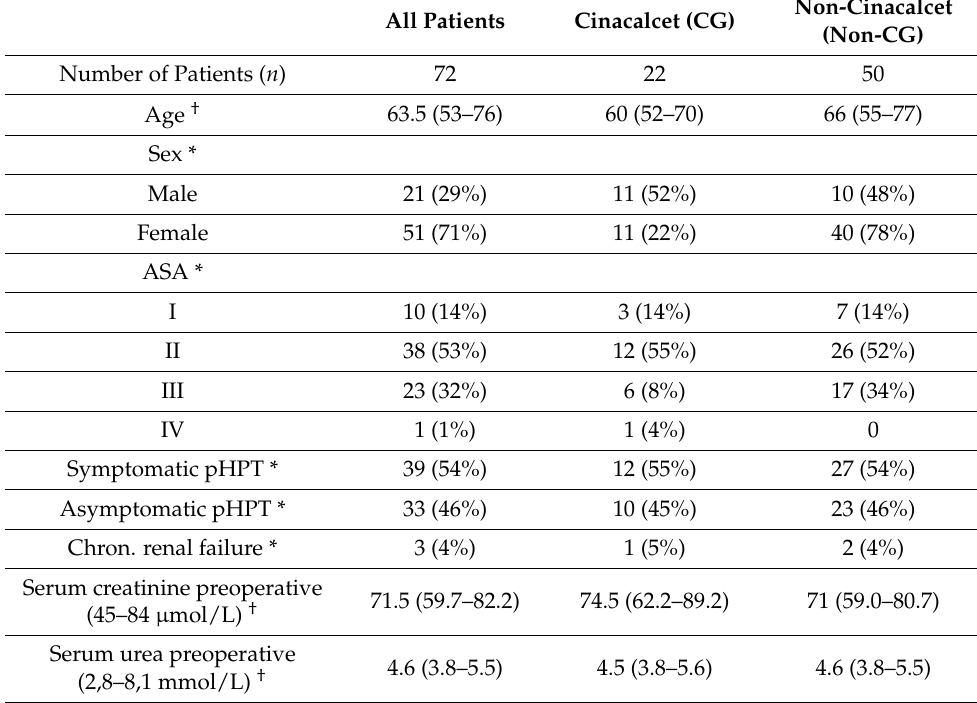
Table 1. Patients’ baseline characteristics.